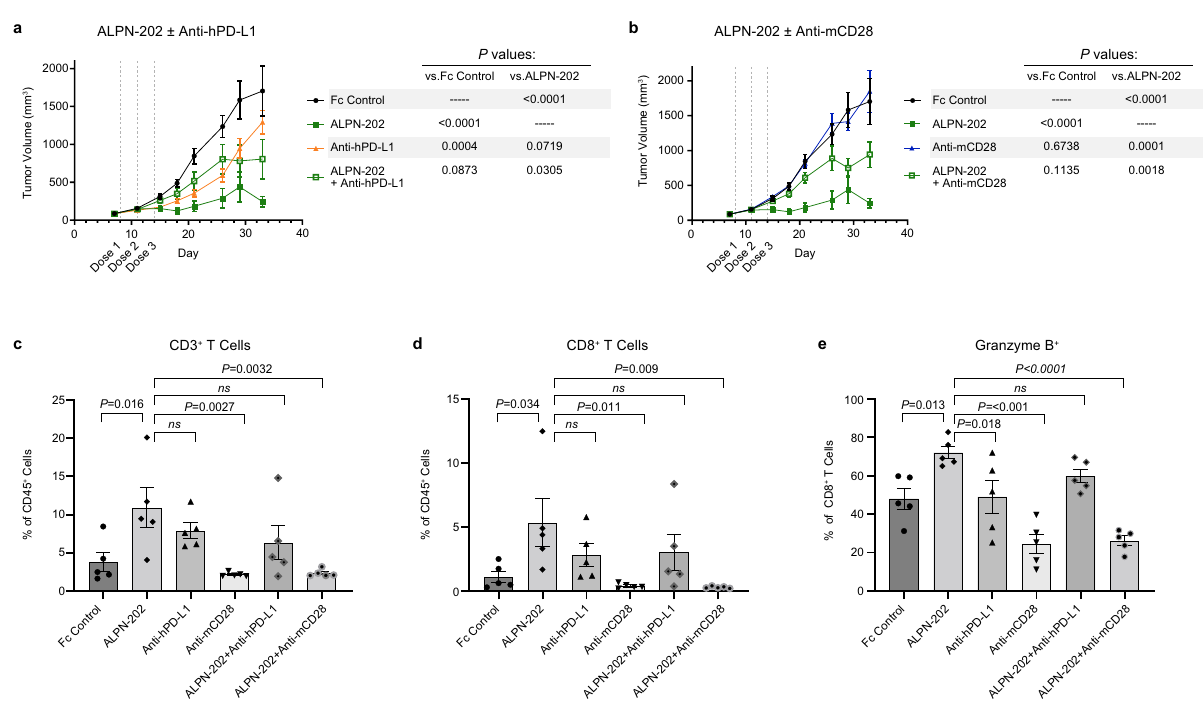
Fig. 6 ALPN-202 increases intratumoral in fl ammatory cell in fi ltrate in part by hPD-L1-dependent mCD28 costimulation. a , b The anti-tumor activity of ALPN-202 was signi fi cantly blocked by combining with ( a ) anti-hPD-L1 or ( b ) anti-mCD28 blocking antibodies ( n = 12 mice/group). Mean tumor volumes ± SEM are shown. Tumors were collected from mice 48 h after the second dose, dissociated, and analyzed by fl ow cytometry. ALPN-202 treatment signi fi cantly increased the percentage of in fi ltrating total CD3 + T cells ( c ), CD8 + T cells ( d ), and granzyme B + CD8 + T cells ( e ) relative to Fc Control treated animals. In each case, this in fl ux in T cells was reduced when ALPN-202 was combined with anti-hPD-L1 or anti-mCD28 antibodies. Statistical signi fi cance was determined by repeated-measures two-way ANOVA for treatment effects ( a , b ) or one-way ANOVA with Dunnett ’ s multiple comparisons test ( c – e ). Bar height indicates mean value ± SEM and symbols represent individual tumor samples ( n = 5 tumors per treatment group) ( c – e ). Source data are provided as a Source Data fi